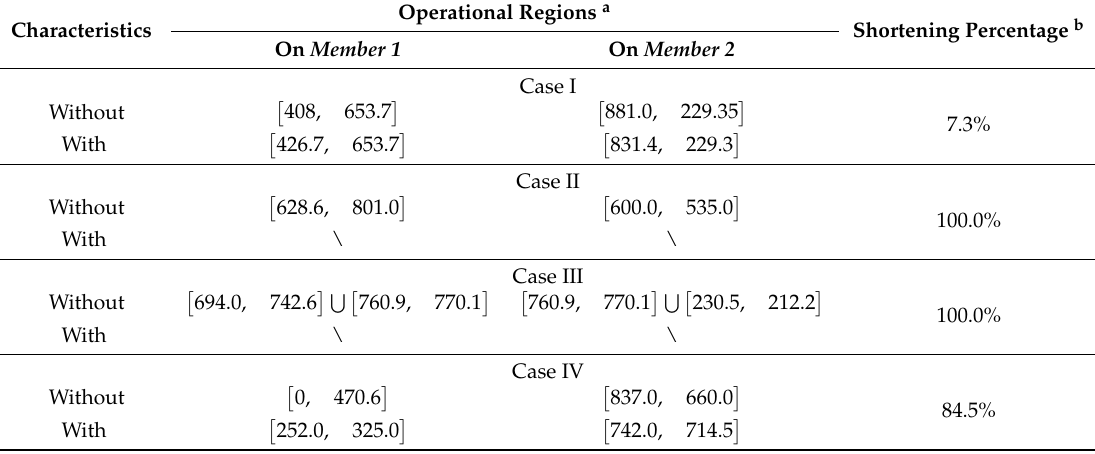
Table 2. Comparison of transition analysis results with and without the consideration of